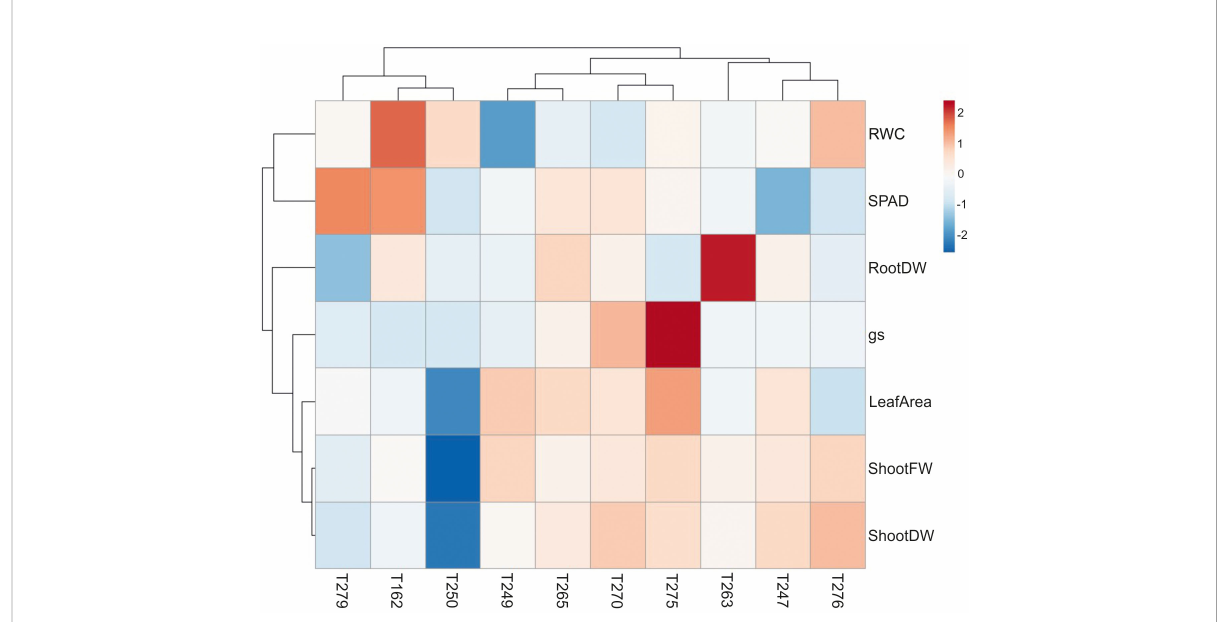
FIGURE 2 Heatmap constructed through ClustVis (http://biit.cs.ut.ee/clustvis/) of percentage differences in physiological and biometric parameters measured in plants of the 10 genotypes analysed (See Supplementary Datasheet S1) subjected to combined stress versus control condition. The red-blue color gradient scaling is indicated, where red and blue colors indicate highest and lowest variations in values measured in stressed plants compared to controls, respectively. Rows and columns are clustered through correlation distance and average linkage. RootDW, Root Dry Weight; gs, Stomatal Conductance; ShootFW, Shoot Fresh Weight; ShootDW, Shoot Dry Weight; RWC, Leaf Relative Water Content; SPAD, Leaf SPAD Values.